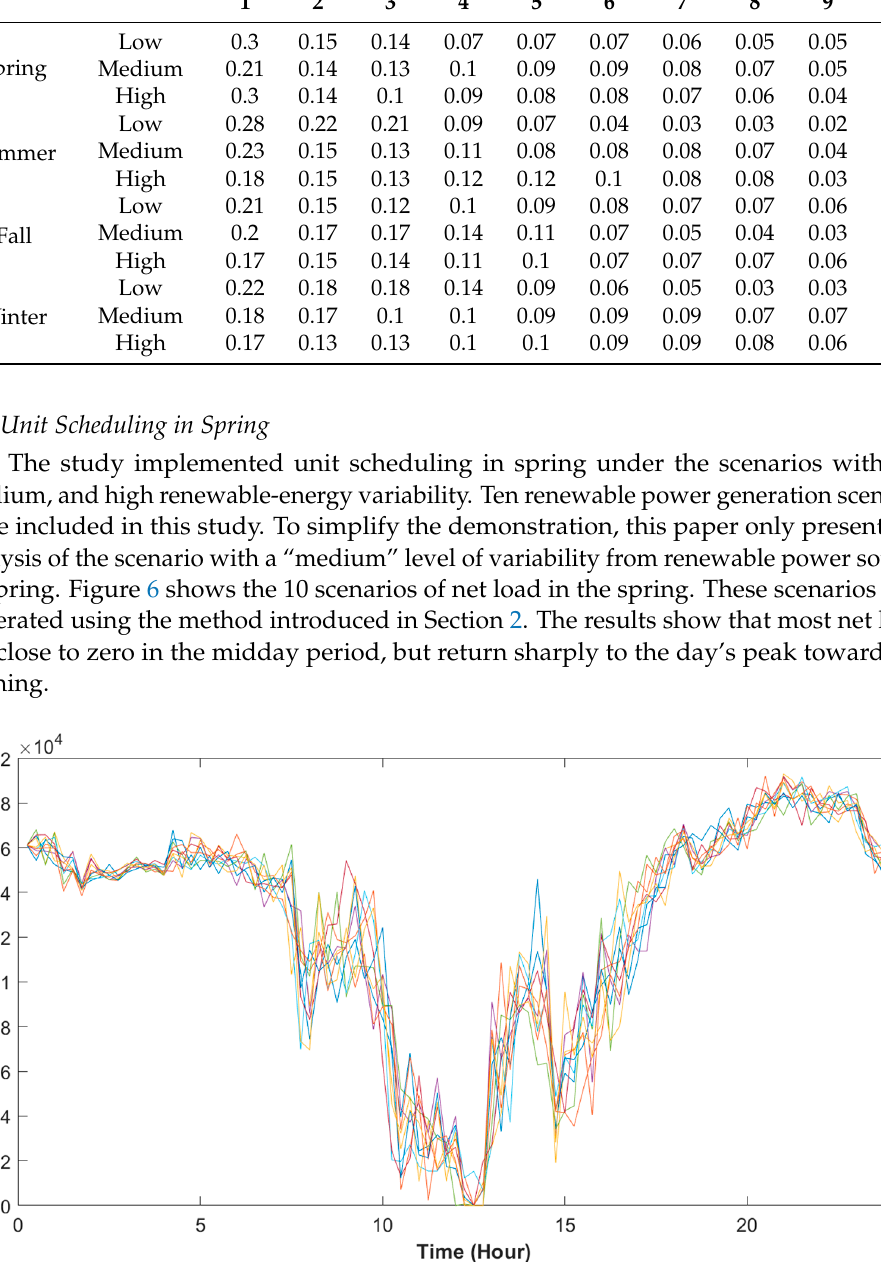
Table 3. Resultant scenarios probability implemented in various seasons and variation levels.